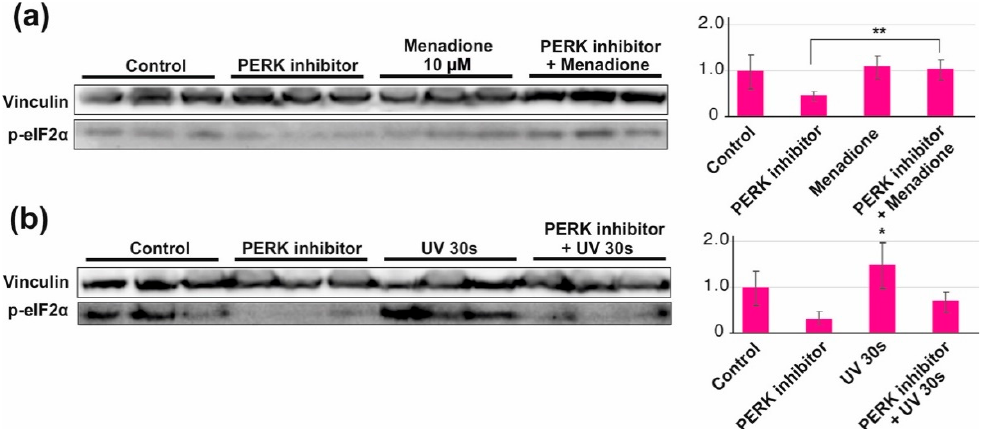
Figure 5. ISR upstream signals after menadione treatment. ( a ) Despite rapid upregulation of ATF4 levels, eIF2 α phosphorylation is not increased in cells treated with menadione for 8 h. While a PERK inhibitor abolishes eIF2 α phosphorylation in untreated cells, steady-state levels are also maintained in menadione-treated cells in the presence of the inhibitor. ( b ) To validate the functionality of the antibody as well as the existence of PERK-eIF2 α signaling in HEK293T cells, the cells were exposed to 1.34 mJ/cm 2 UVB (305 nm) for 30 s. Addition of PERK inhibitor 4 h prior the exposure prevented eIF2 α phosphorylation. Vinculin was used as a loading control. * p < 0.05, ** p < 0.01 ANOVA/Tukey.